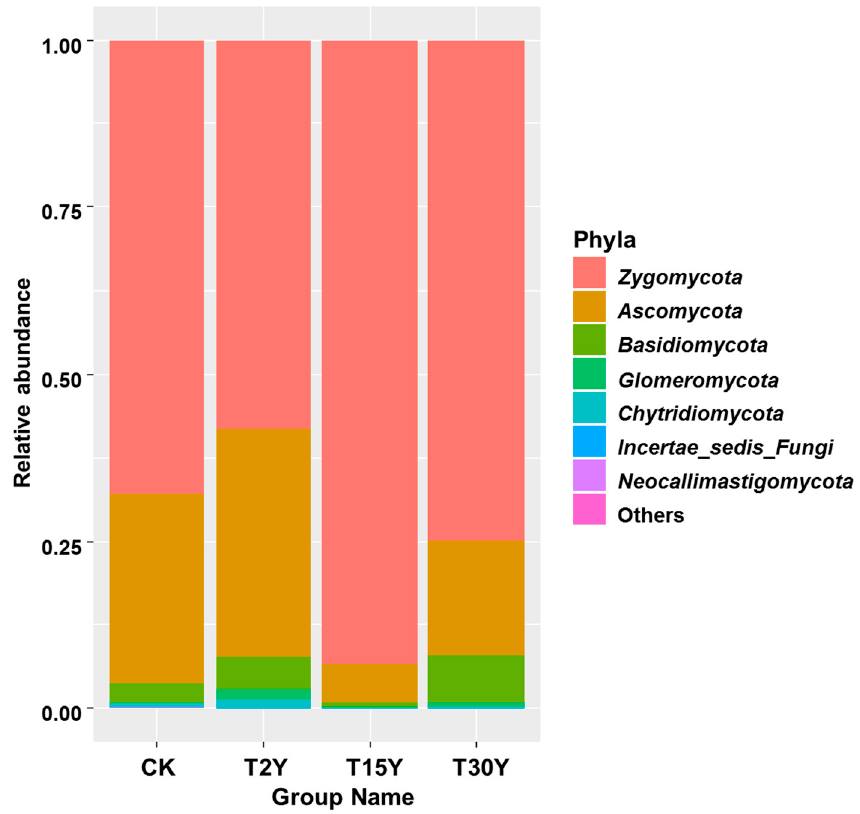
Figure 4. Relative abundance of top fungal phyla in control and different age monoculture tea fields. “Others” shows the sum of the relative abundances of all phyla except the eight listed.